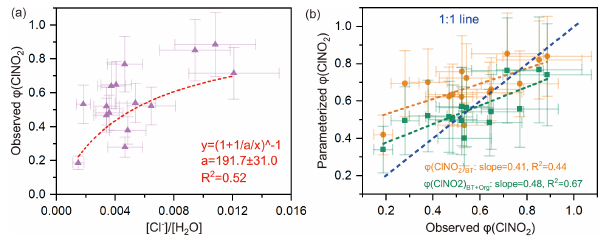
Figure 4. Influencing factors and parameterizations of ϕ (ClNO 2 ). (a) Dependence of ϕ (ClNO 2 ) on the [Cl − ]/[H 2 O] ratio. Dashed red line shows nonlinear fitting of ϕ (ClNO 2 ); “a” represents the k 4 /k 3 ratio in Eq. (8). (b) Comparison of parameterized ϕ (ClNO 2 ) and observed ϕ (ClNO 2 ), where ϕ (ClNO 2 ) BT denotes the pa- rameterization proposed by Bertram and Thornton (2009), and ϕ (ClNO 2 ) BT + Org represents the revised parameterization used in this study (see Eq. 11).